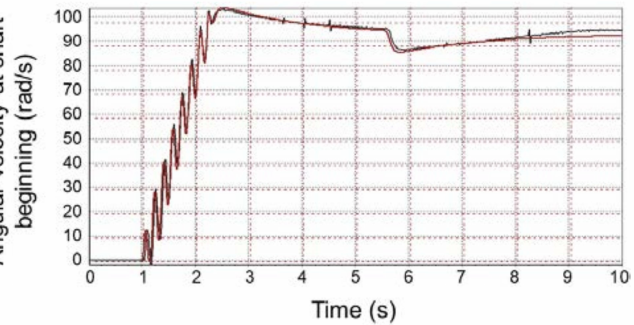
Figure 2. Comparison of the results of simulation tests (brown line) and experimental tests (black line) for the angular velocity at the beginning of the shaft [21].